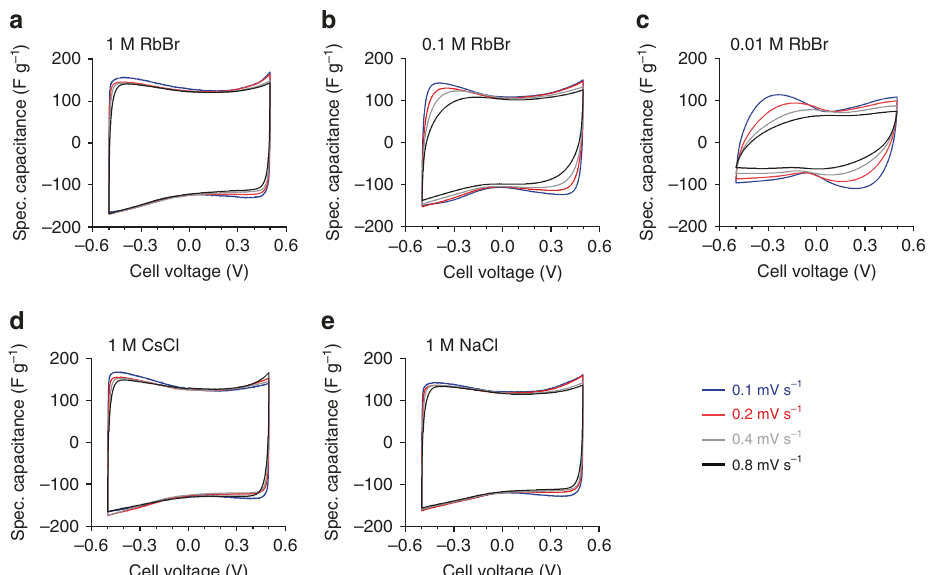
Fig. 1 Cyclic voltammograms of all investigated in situ cells. Speci fi c capacitance versus cell voltage for the in situ cells using the same activated carbon as working electrode (WE) material and different aqueous electrolytes. 1 M RbBr ( a ), 0.1 M RbBr ( b ), 0.01 M RbBr ( c ), 1 M CsCl ( d ), and 1 M NaCl ( e ) tested at four different scan rates (0.1 – 0.8 mV s − 1 ) with ± 0.5 V applied cell